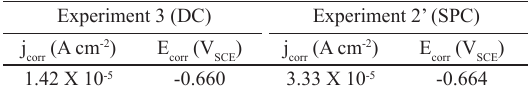
and E values obtained from the Tafel extrapolation Table 7. j corr corr of the polarization curves in NaCl 0.5 mol L -1 for the